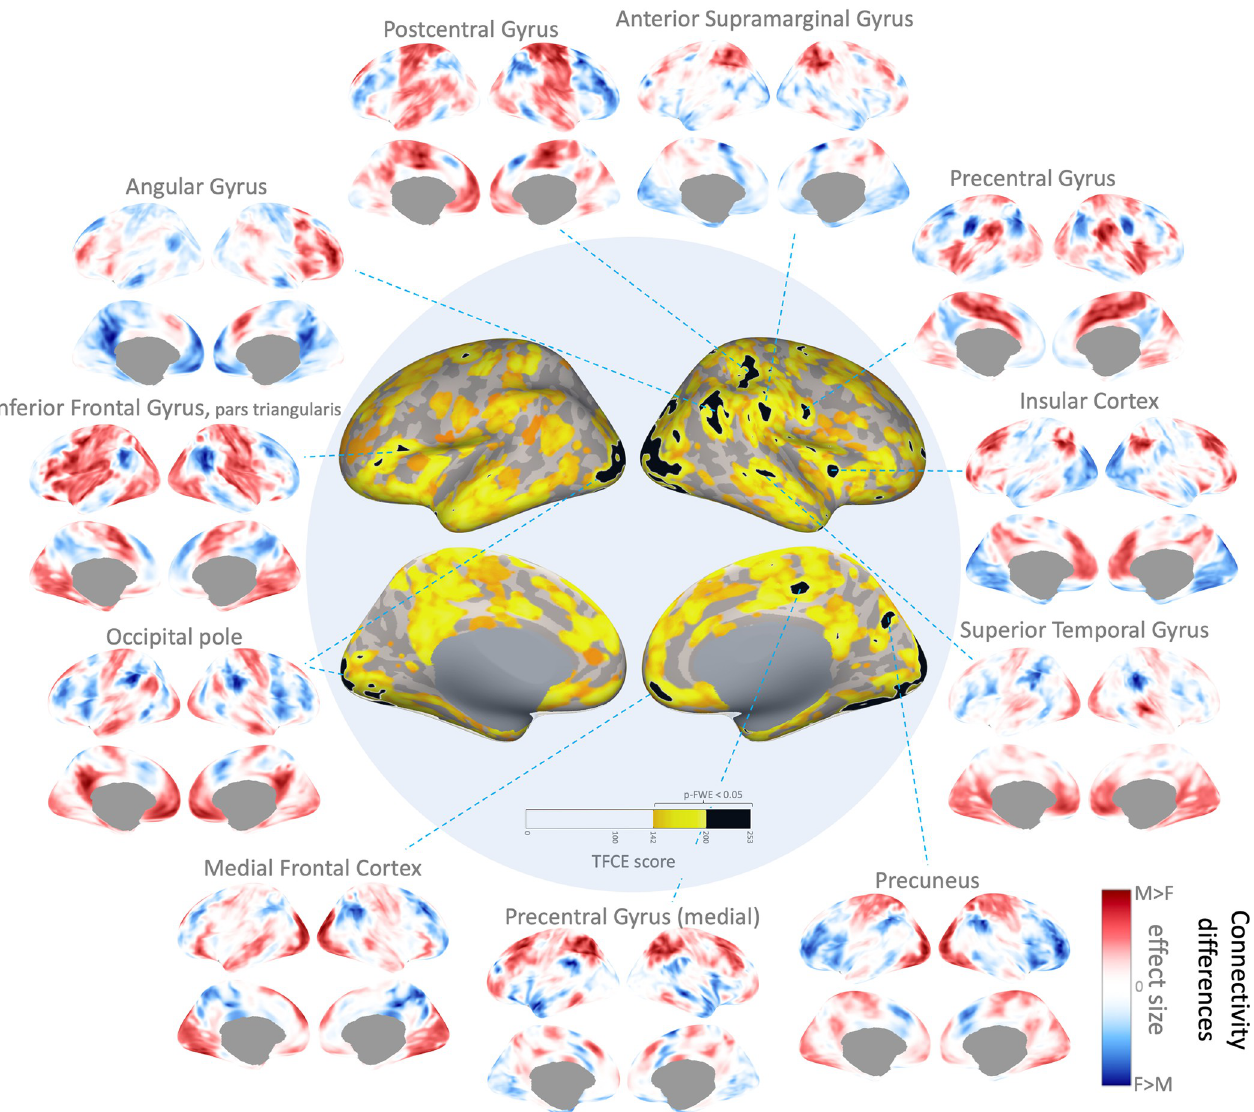
Fig 2. Fc-MVPA results evaluating gender-related differences in connectivity. Central figure shows left- and right- hemisphere medial (bottom) and lateral (top) views of the main fc-MVPA results showing areas with significant gender-related differences in functional connectivity (highlighted in yellow and black, TFCE statistics p-FWE < 0.05). Among all significant results a reduced subset showing some of the strongest effects are highlighted in black, and the effect-sizes within these areas (pattern of differences in connectivity with each area between male and female subjects) are shown in the additional circular plots (yellow indicating higher connectivity in male compared to female subjects, and blue indicating higher connectivity in female compared to male